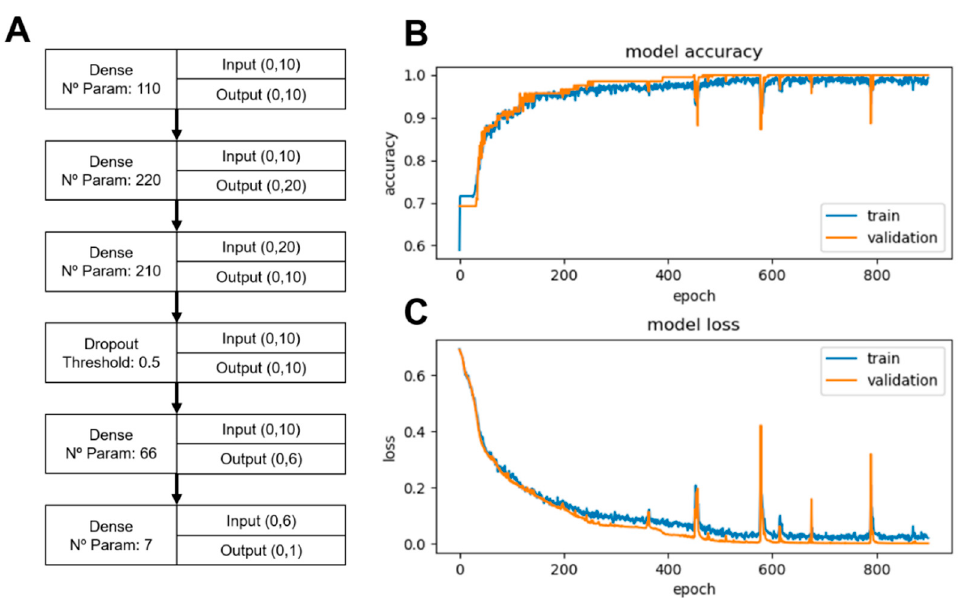
Figure 5. Feed Forward Neural Network Architecture and Learning Curve. ( A ) Visualization of the Neural Network Architecture including input and output shape for each layer, n° of adjustable parameters, and the type of layer. A graphical representation of this has been provided as Supplementary Figure S1. ( B ) Accuracy learning curve for validation and training over epochs. ( C ) Loss learning curve for validation and training over epochs.